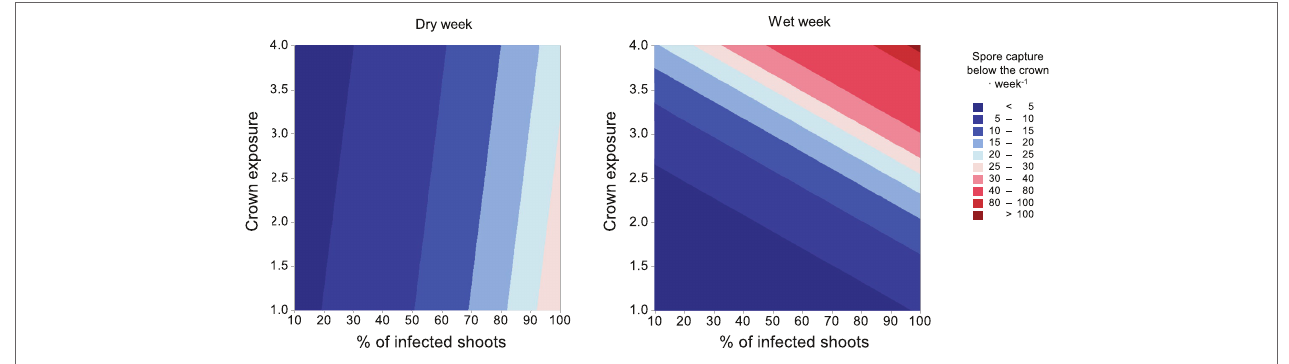
FIGURE 6 | Weekly spore captures depending on the rain conditions, tree exposure, and percentage of infected shoots. Spores were trapped under each tree ( n = 40 trees/traps during dry period, and n = 39 during wet period). Tree exposure ranges from 0 to 4 and measures how exposed to rain and wind was the crown of the tree: 0, tree surrounded by other trees; 4, tree growing in open space. No spore trap was placed under a tree with less than 10% defoliation or with a lower exposure than